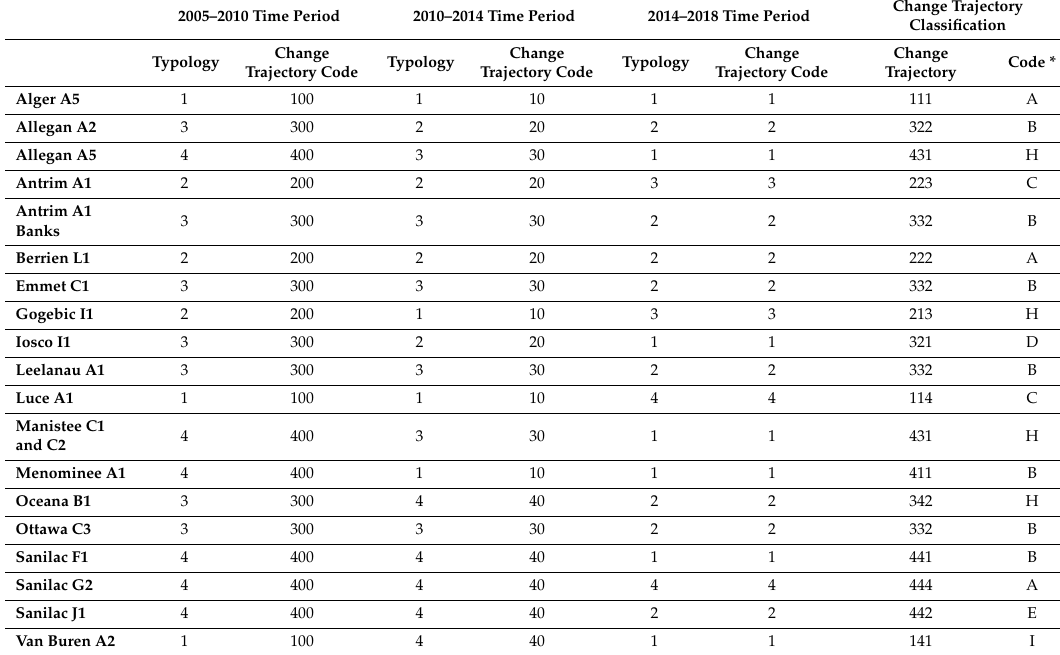
Table 2. Change Trajectory of